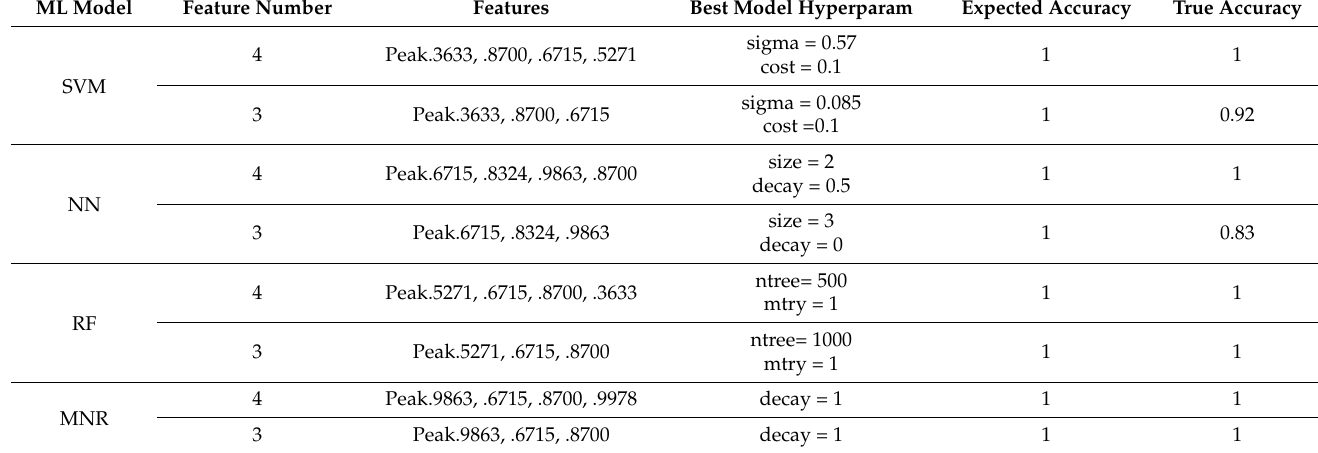
Table 1. Expected and true performance of the best final classifiers, optimized in terms of feature and model hyperparameters. The expected ML model accuracy was evaluated across all 10 CV folds of the training dataset, while the true ML accuracy was assessed on the external test